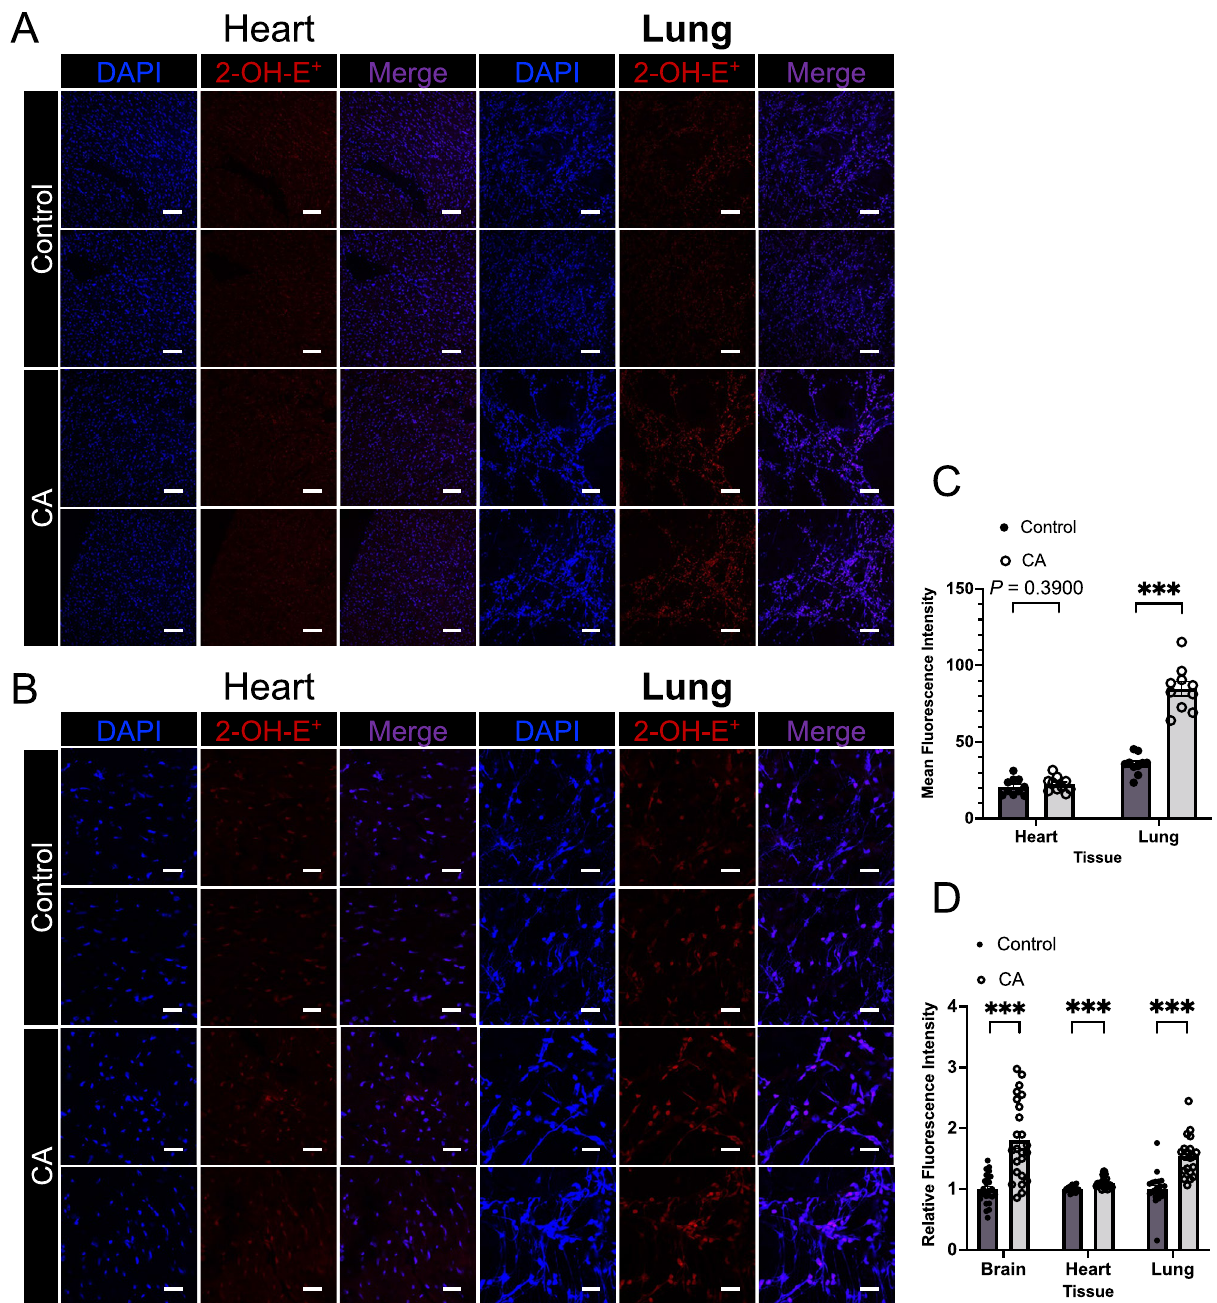
Figure 2. Superoxide production in tissues after cardiac arrest detected by DHE staining and fluorescence microplate reader. ( A ) Representative low-power field images of DHE staining in heart and lung. The left 3 columns are the images of heart and right 3 columns are those of lung. Upper 2 and lower 2 panels show control group and cardiac arrest group, respectively. Blue fluorescence as DAPI, red fluorescence as 2-hydroxyethidium (2-OH-E + ), and merged panels are shown for each image. Scale bars indicate 100 µm. ( B ) Representative high- power field images of DHE staining. Scale bars indicate 25 µm. ( C ) Mean fluorescence intensity of 2-OH-E + in heart and lung. Ten low-power field images of each groups are analyzed and data are shown as mean ± SEM with scatter dot plot. *** P < 0.001, Mann–Whitney test. ( D ) Relative fluorescence intensity of 2-OH-E + in brain, heart, and lung were detected on fluorescence microplate reader (excitation wavelength; 485 nm, emission wavelength; 570 nm). Multiple well measurement of 7 paired protein samples from tissue homogenate in brain and 5 paired samples in heart, lung was applied and data were shown as mean ± SEM with scatter dot plot. *** P < 0.001, Mann–Whitney